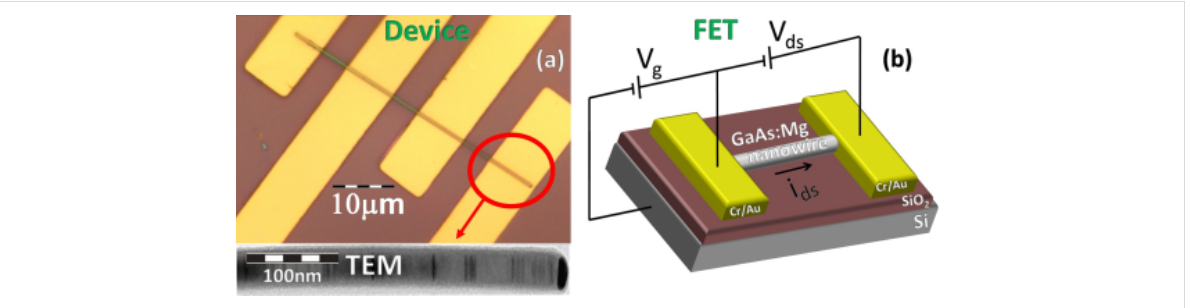
Figure 1: (a) Optical image of the back-gate GaAs:Mg nanowire FET device. The inset shows an illustrative TEM image of a Mg-doped GaAs nano- wire showing the characteristic alternated WZ/BZ segments. (b) Schematic of the back-gated FET device.